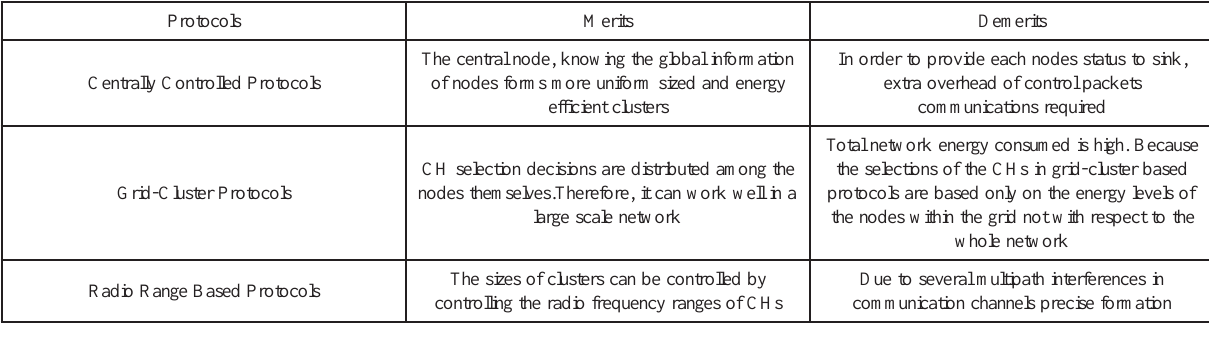
TABLE 1. MERITS AND DEMERITS OF LOAD BALANCING THROUGH UNIFORM